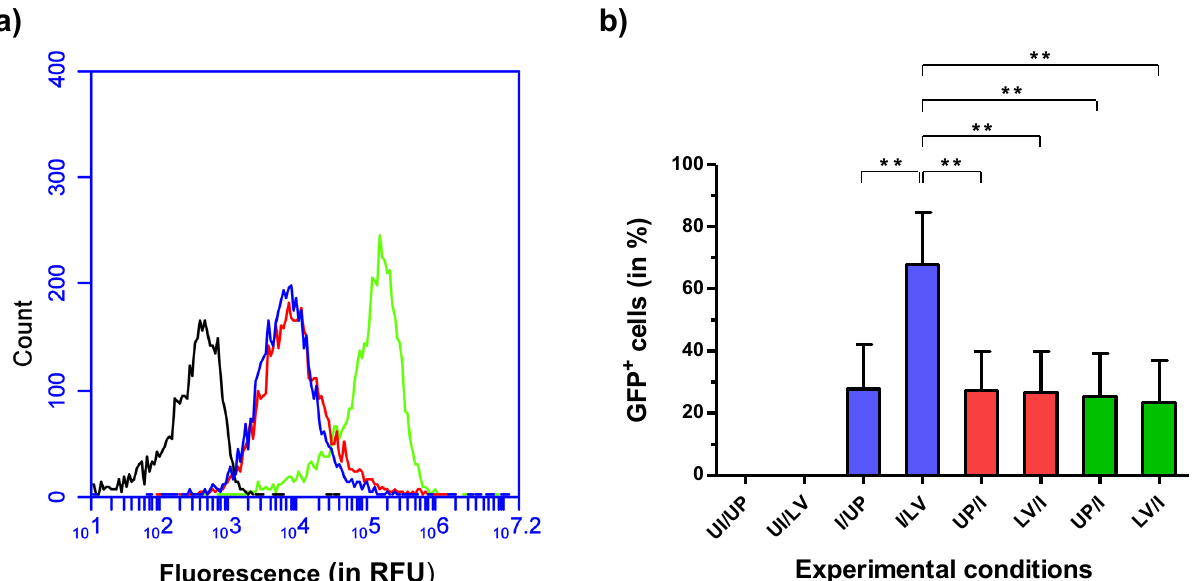
Figure 3. Contribution of electropermeabilization and electrophoretic effect in the GFP conversion enhancement induced by LV pulse application in infected L929 cells. ( a ) Flow cytometry detection of intracellular YO-PRO-1 to assess electropermeabilization of L929 cells subjected to HV versus LV pulse application. L929 cells were exposed to YO-PRO-1, immediately subjected to HV or LV pulses (amplitude = 12 kVm −1 ) and, 40 min later, to flow cytometry analysis (excitation: 488 nm, emission: 530/30 nm). The graph represents cell distribution (count) according to fluorescence (in RFU) by the YO-PRO-1 dye (logarithmic scale). Cells not exposed to YO-PRO-1 (black line, auto-fluorescence), cells exposed to YO-PRO-1 without application of electric pulses (blue line) or subjected to LV or HV pulses (red and green line, respectively). ( b ) GFP + cells (in %) as a function of the order and time interval between LV pulse application and rAd infection. L929 cells were infected with rAd at MOI = 10 4 vp/cell, 5 min before (blue columns) or 1 min (red columns) to 5 min (green columns) after LV pulse delivery. The GFP + cells were scored by flow cytometry 48 h after